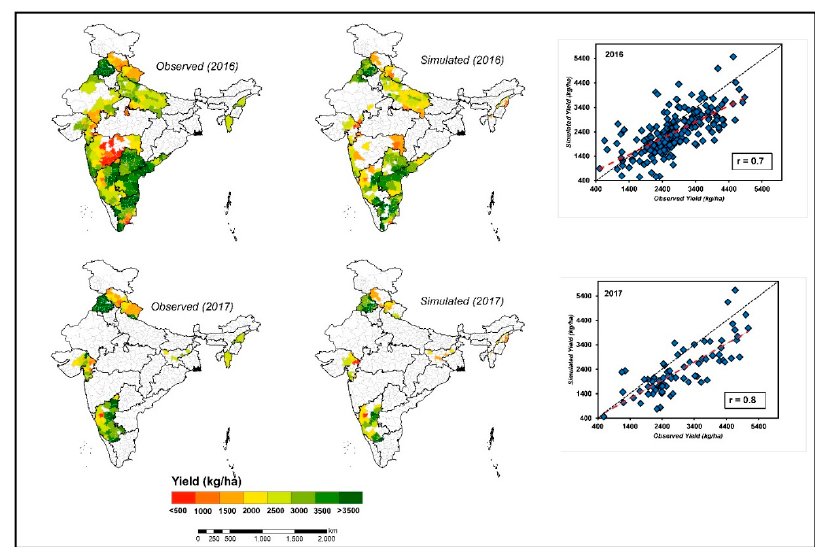
Figure 7. The spatial distribution comparison between aggregated district-level simulated yield and district-level observed yields for the years 2016 and 2017 and the scatterplot between observed and simulated yields for the years 2016 and 2017. There were fewer districts in simulated yields compared to observed yields due to the restriction of the crop